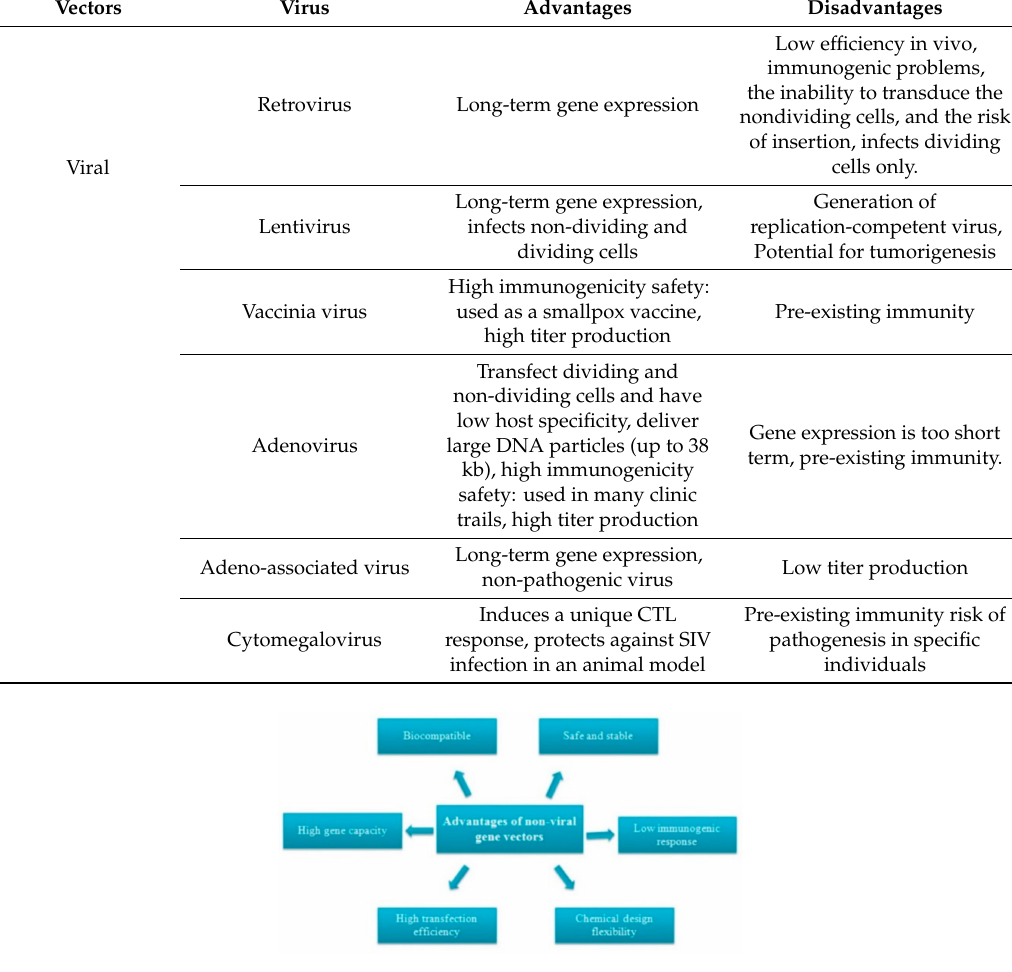
Figure 1. Advantages of non-viral